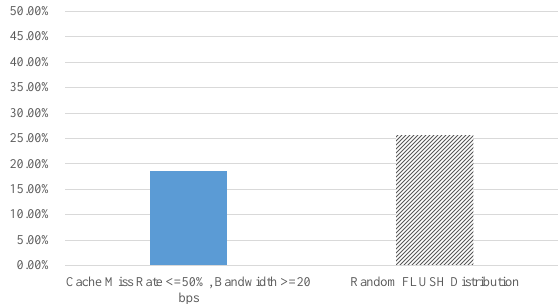
Figure 7. Performance overhead with and without adaptive